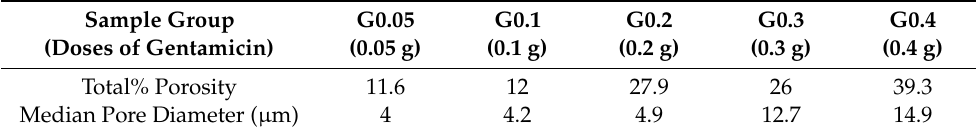
Table 7. Porosity of PMMA bone cement with different gentamicin concentrations.